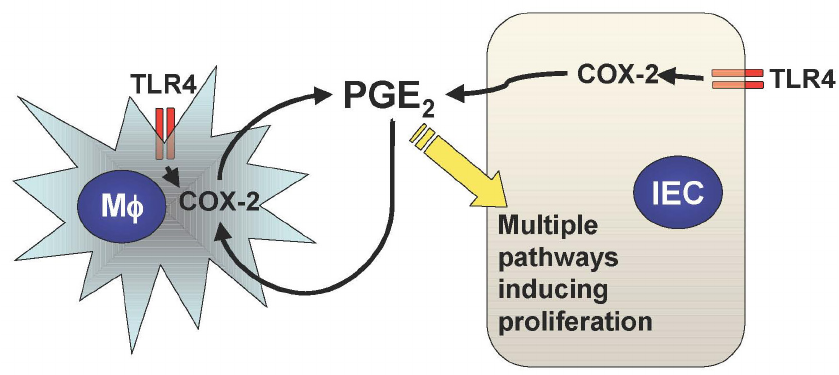
Figure 2. COX-2 and PGE form a positive feedback loop within the intestinal mucosa. 2 is Mucosal TLR4 expression is increased in chronic intestinal inflammation and PGE 2 synthesized by COX-2 induction. The PGE in turn stimulates COX-2 production in 2 mucosal macrophages (M φ s) which causes further release of PGE , which forms a positive 2 feedback loop thus inducing